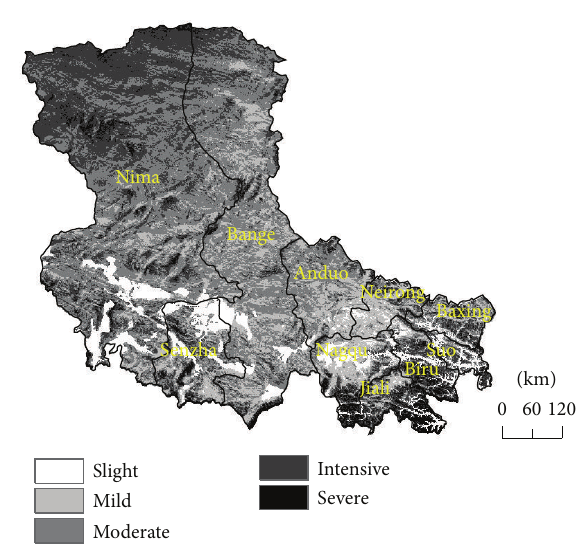
Figure 3: Classification map of the quantity of freeze-thaw erosion in Silingco watershed